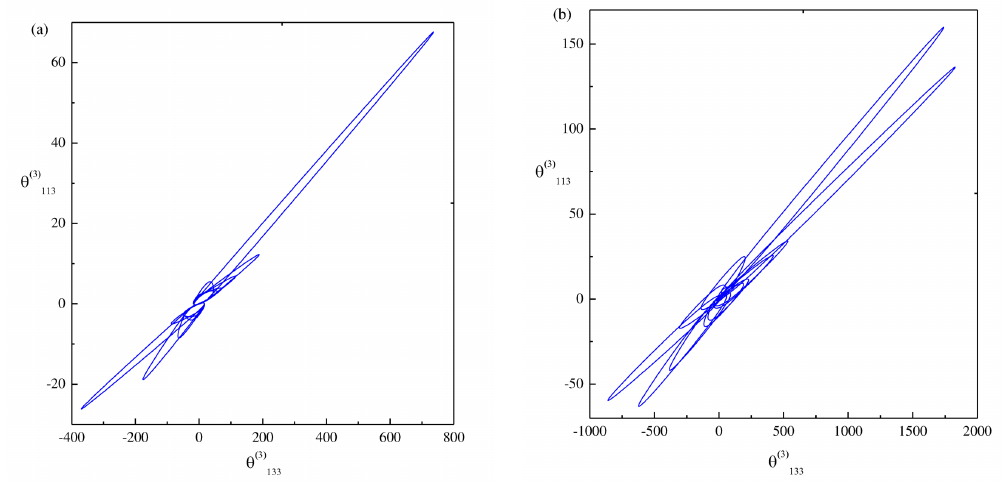
( 3 ) with respect to θ 133